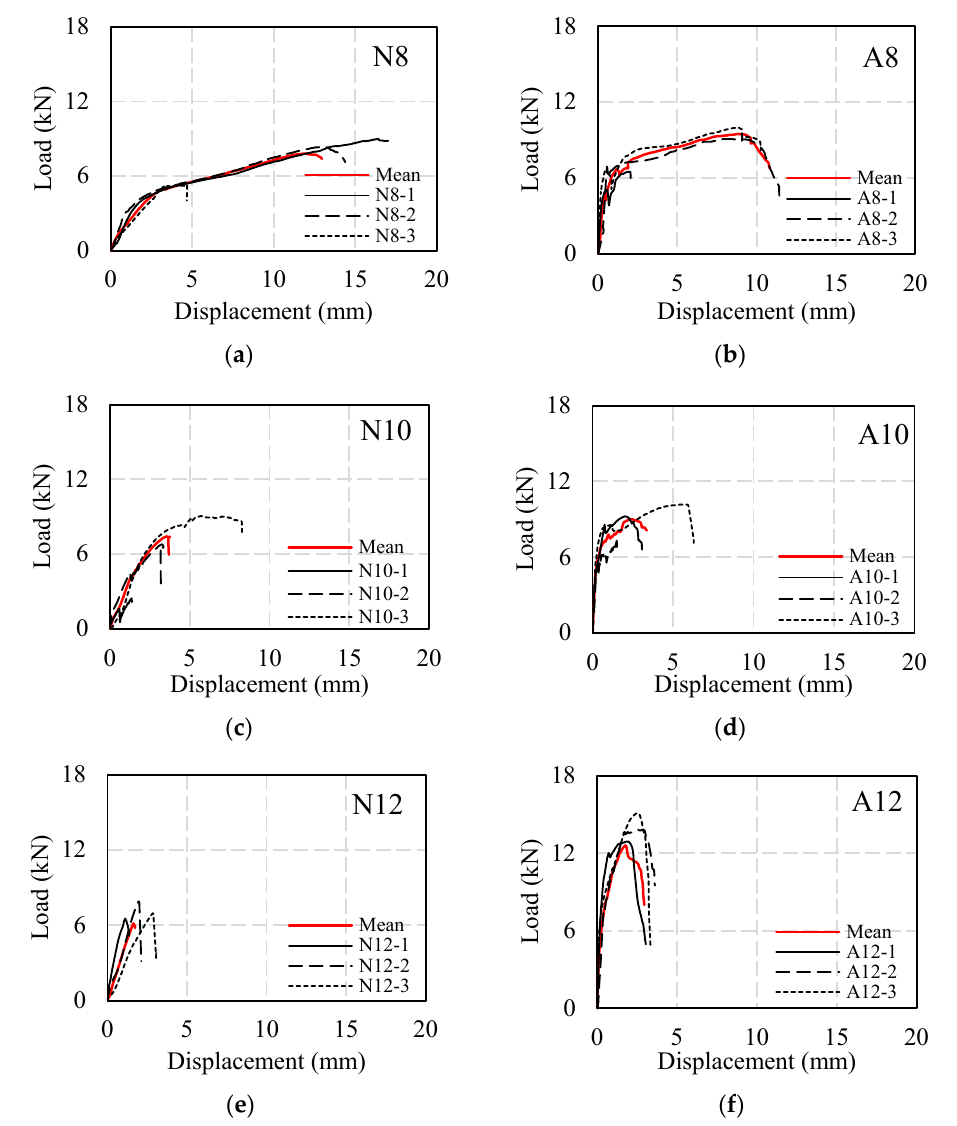
Figure 12. The load—displacement diagram of the shear test. ( a ) N8-type; ( b ) A8-type; ( c ) N10-type; Table 9. The experimental result of the shear test.